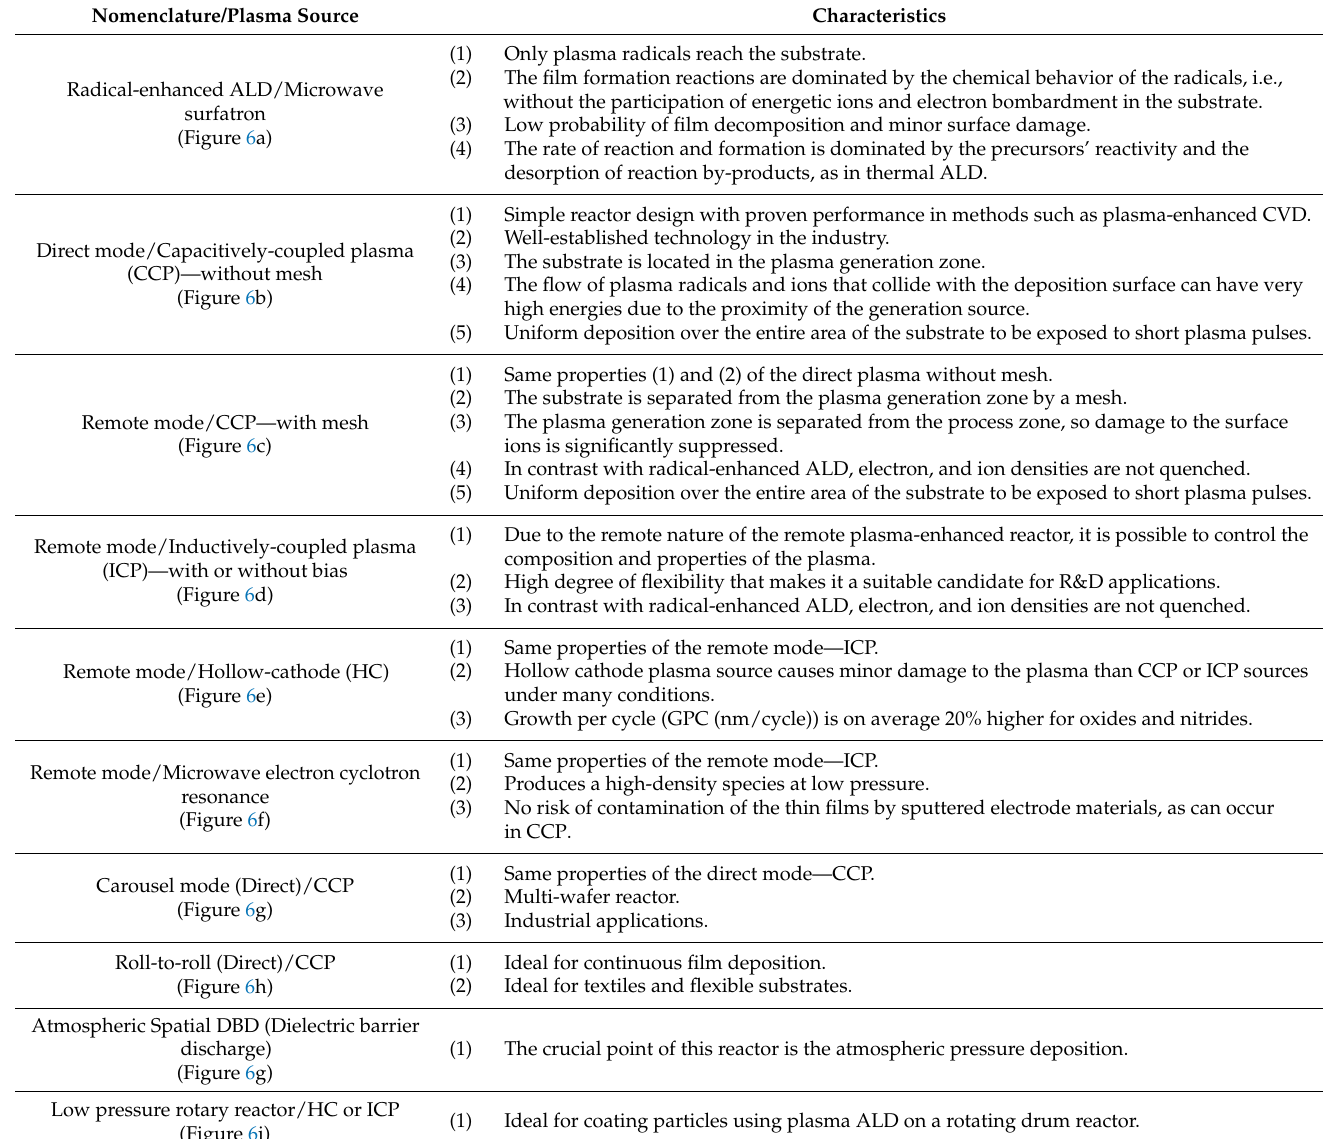
Table 2. Variety of reactors used on plasma- assisted